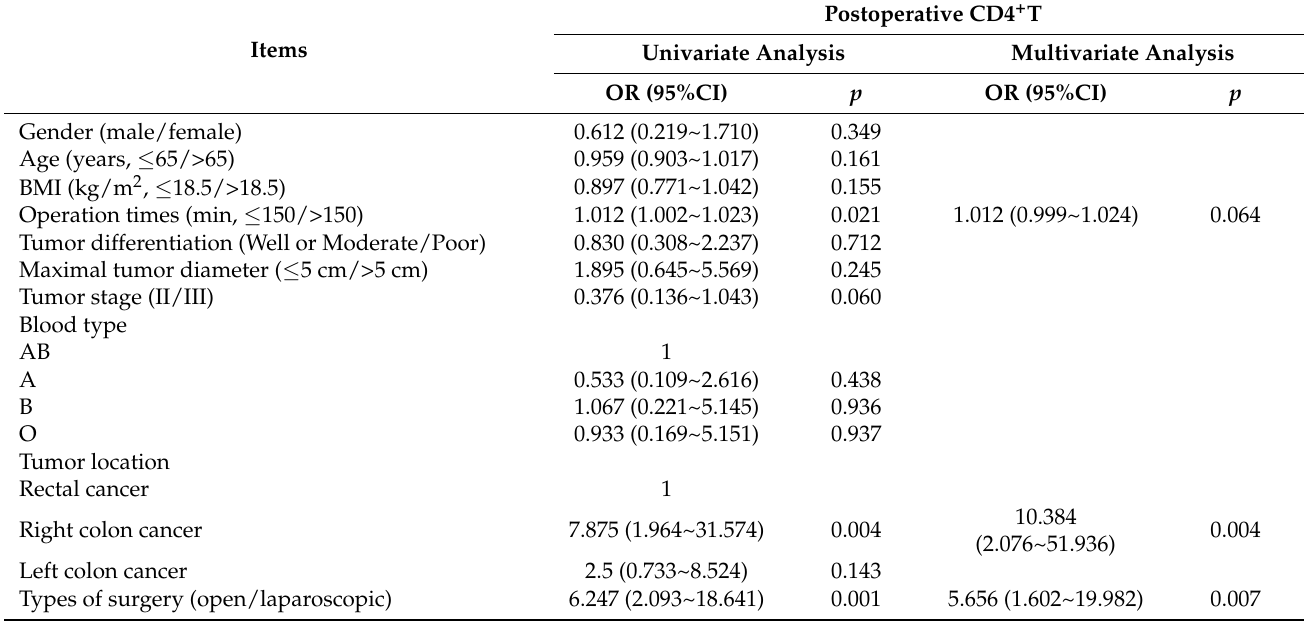
Table 4. Logistic regression analysis of the patient’s postoperative CD4 + T.